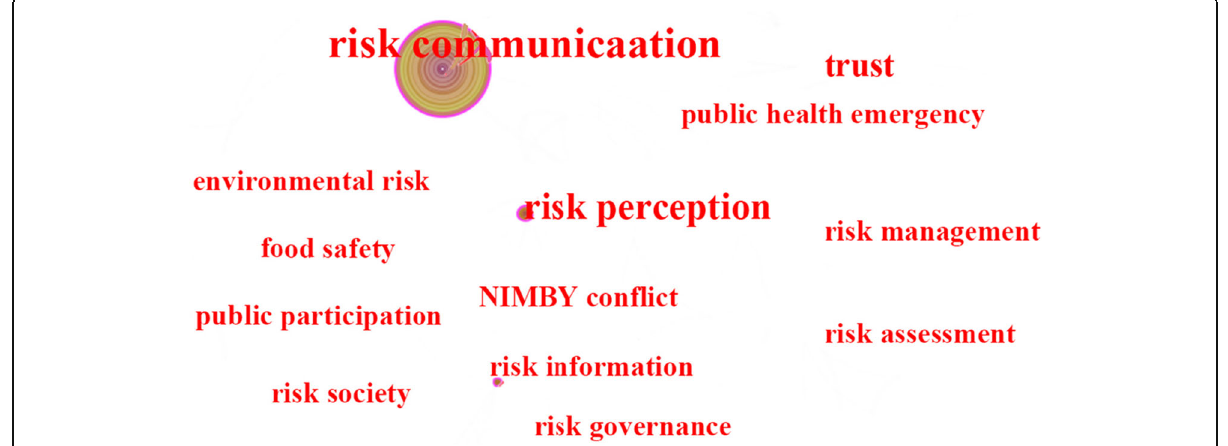
Fig. 5 Keyword co-occurrence network of Chinese database